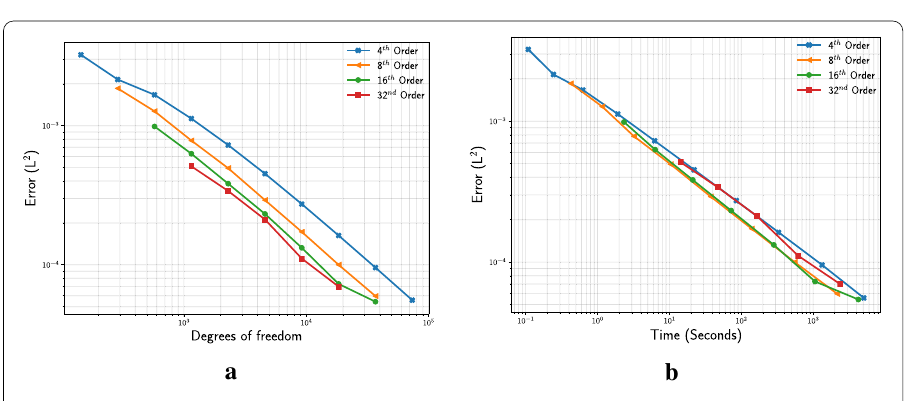
a b Fig. 7 L 2 Error in the reflected acoustic pulse with respect to computational effort needed. a On the left: the L 2 Error for various spatial orders over the required memory in terms of degrees of freedom. b On the right: same runs, but over the computational effort in terms of running time in seconds. All simulations were performed on a single node with 12 cores using 12